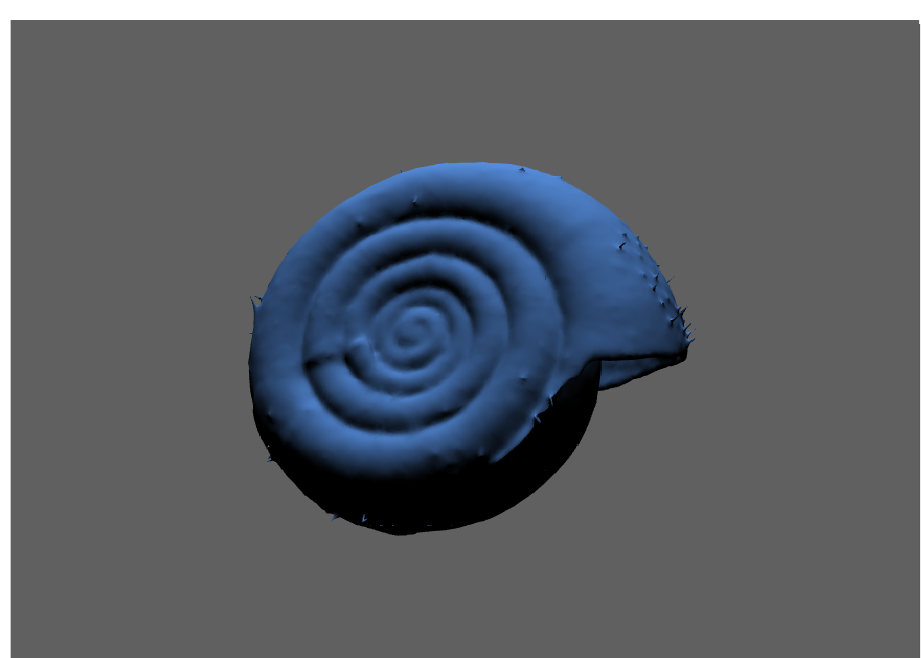
Figure 16. Interactive 3D-model of Helicodonta obvoluta (9 mm shell